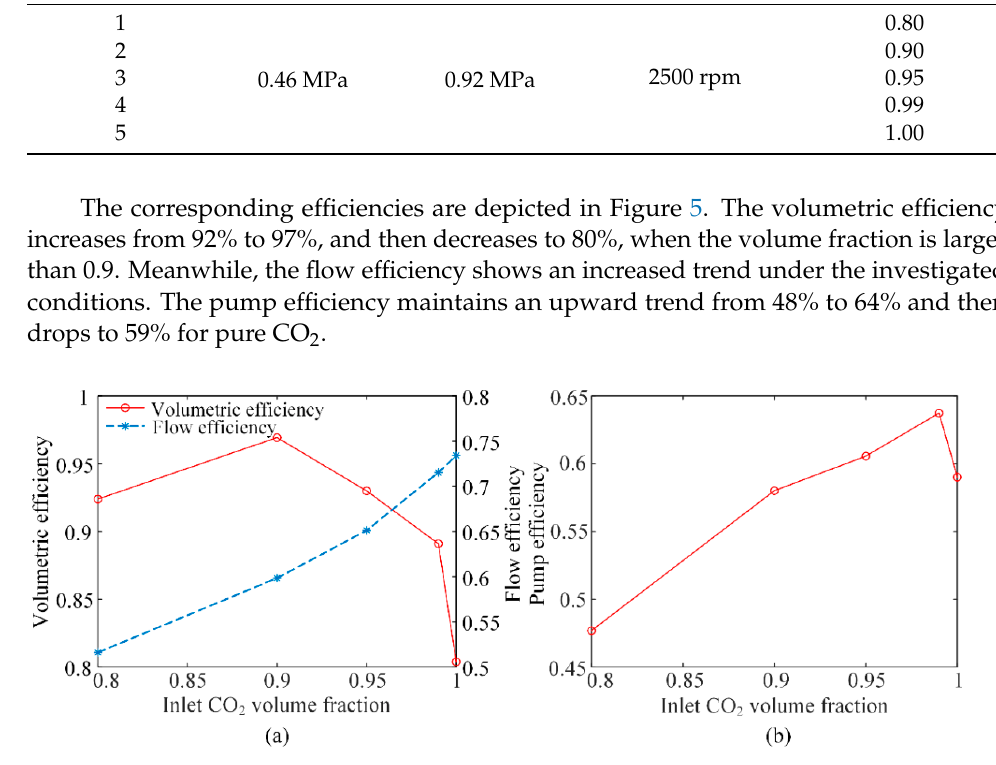
Figure 5. Efficiencies at different inlet CO 2 volume fractions. ( a ) volumetric efficiency and flow efficiency; ( b ) pump efficiency.